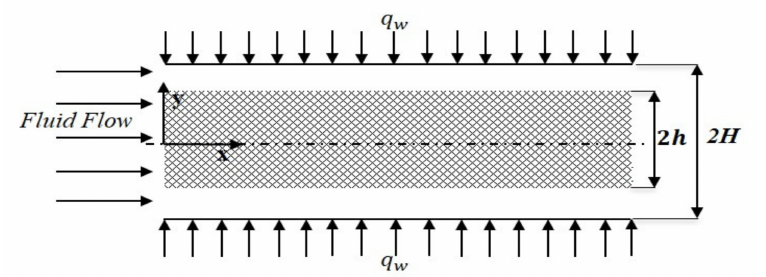
Figure 1. Schematic diagram of the